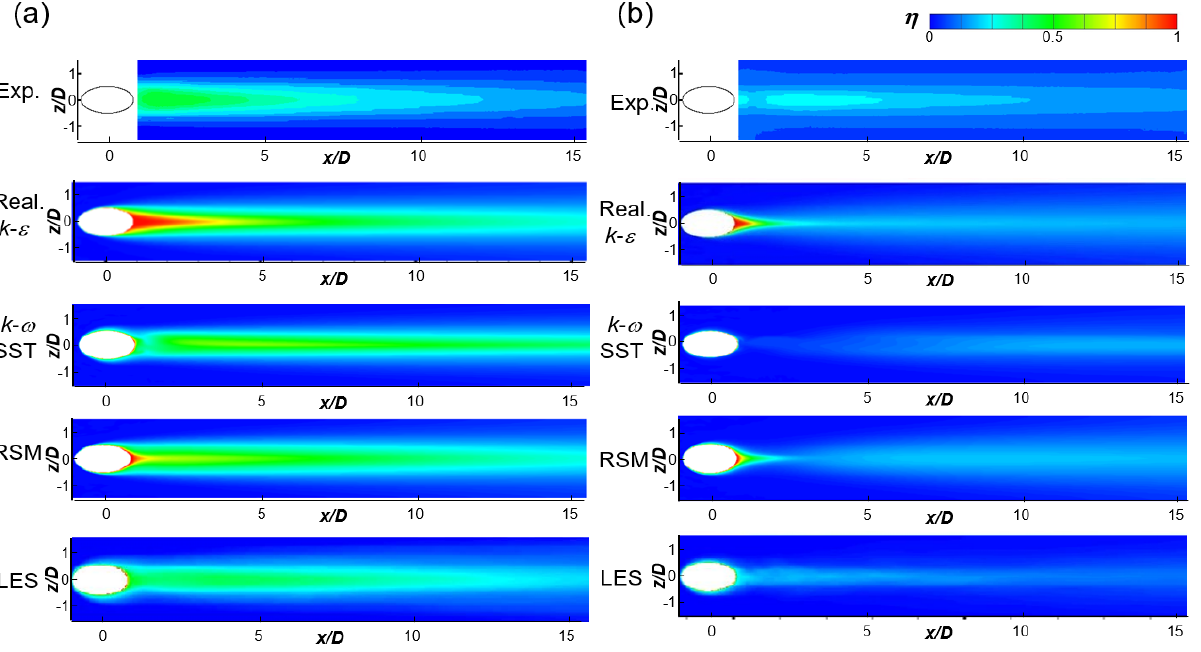
Figure 5. Local adiabatic film-cooling effectiveness distributions [5]: ( a ) M = 0.5 and ( b ) M = 1.0.